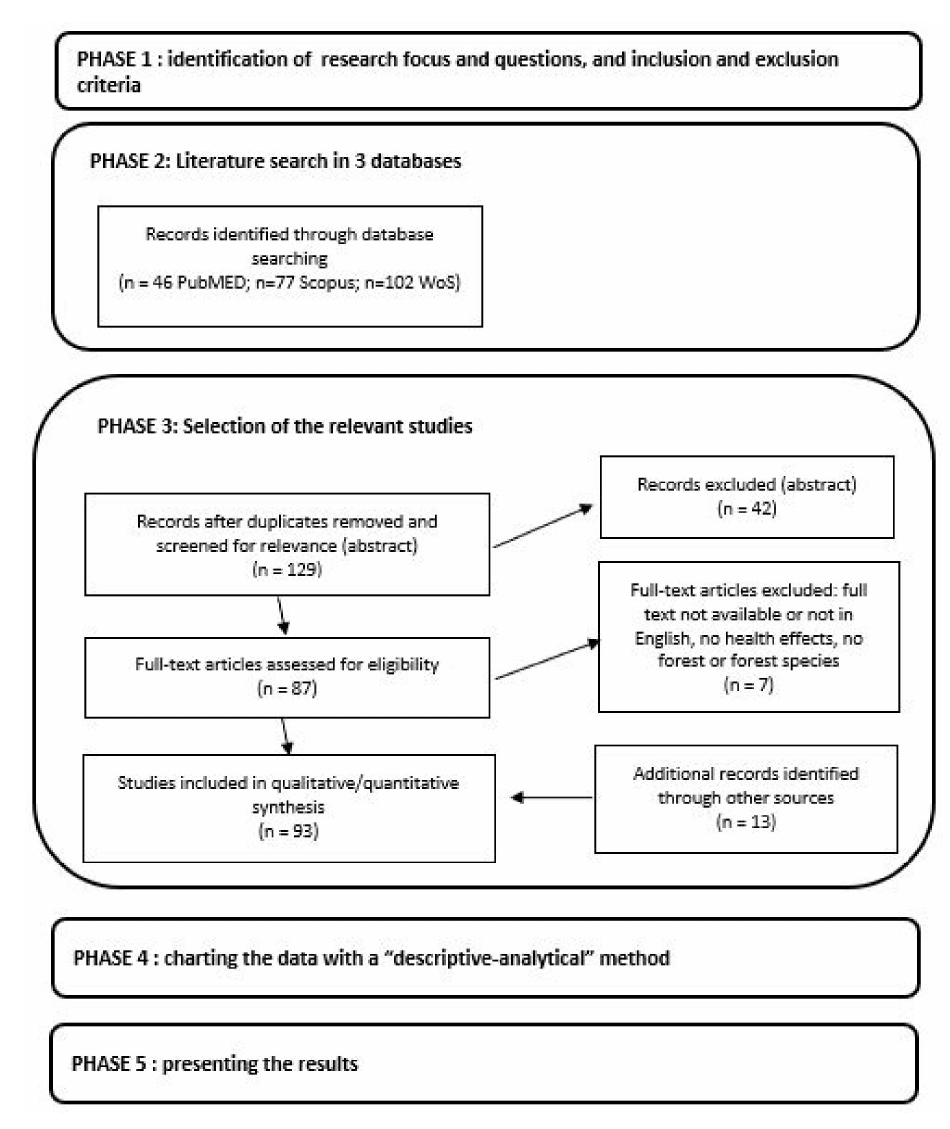
Figure 1. Flow diagram illustrating the 5 phases of the review incorporating Preferred Reporting Items for Systematic Reviews and Meta-Analyses (PRISMA)